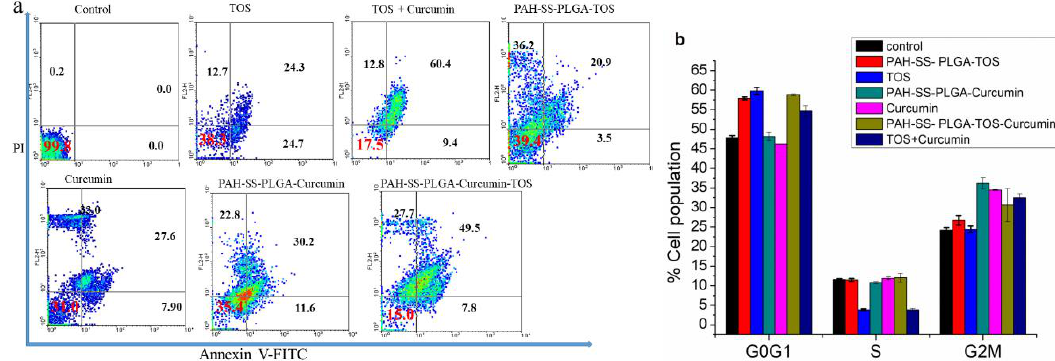
Figure 5. ( a ) Apoptosis assay of free TOS, free curcumin, free TOS + free curcumin, and TOS/curcumin-loaded micelles and ( b ) cell cycle analysis of free TOS, free curcumin, and TOS/curcumin-loaded micelles using PAN02 pancreatic cancer cells. Note: The concentration of free TOS and TOS in the micelles was 30 μg/mL, whereas the concentration of free curcumin and curcumin in the micelles was 15 μg/mL. In addition, for the combination treatments, 30 μg/mL and 15 μg/mL were used together for TOS and curcumin, respectively. Data are expressed as mean ± SD values (n = 3). (* p < 0.05, ** p < 0.01, *** p < 0.001).